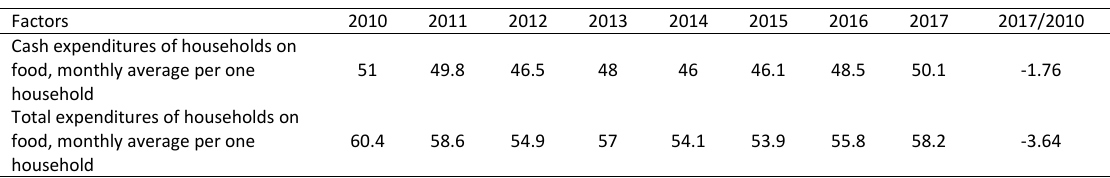
Table 4: The share of total and cash expenditures of Ukrainian households for food in 2010-2017, in percentage in total structure (State Statistics Service of Ukraine, 2018d) Factors